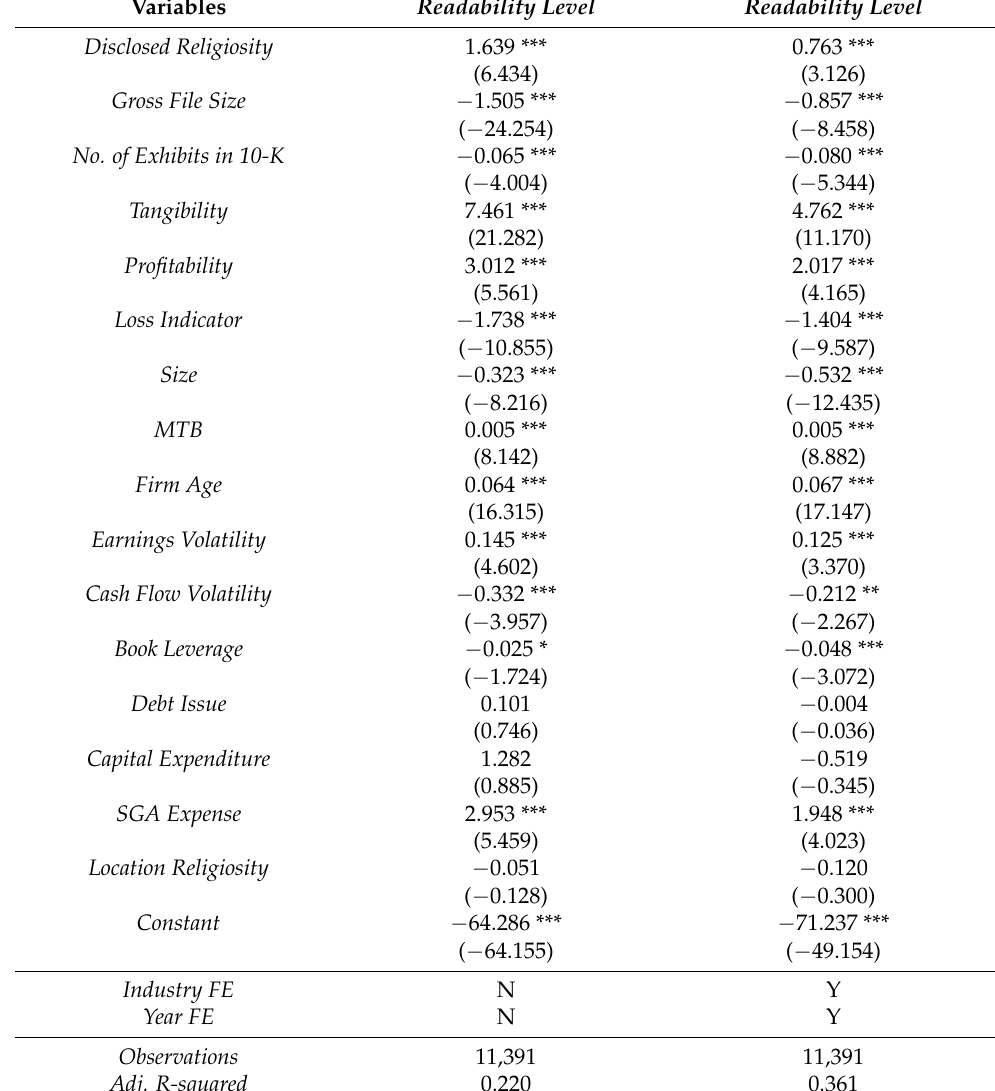
Table 2. Impact of Executive Level Religiosity on Annual Report